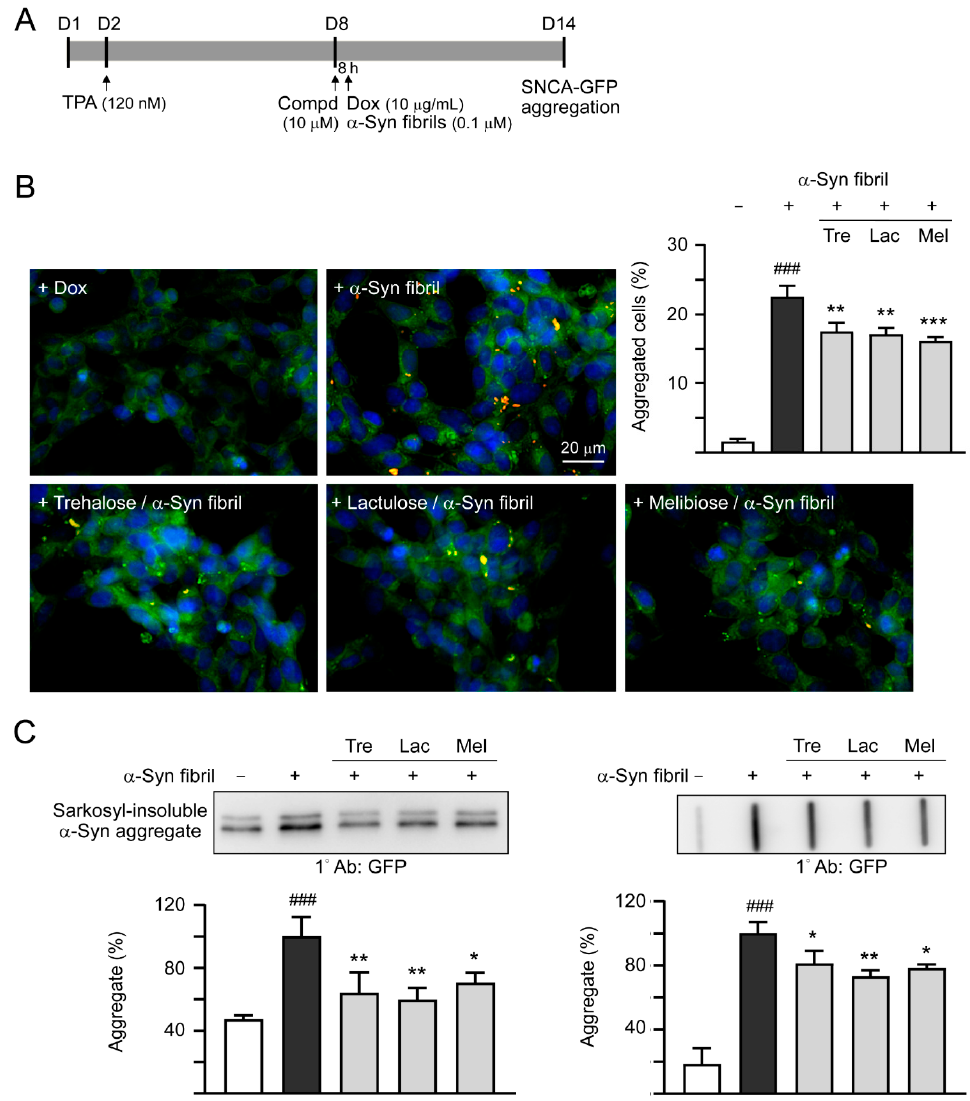
Figure 5. α -Synuclein aggregation analysis on SNCA-GFP SH-SY5Y cells. ( A ) Experimental flow chart. SNCA-GFP SH-SY5Y cells were seeded on day one, and added with TPA (120 nM) on day two to promote DAergic differentiation. On day eight, trehalose, lactulose, or melibiose (100 μ M) was added to the cells for 8 h, followed by induction of SNCA-GFP expression with doxycycline (Dox; 10 μ g/mL) and addition of preformed α -synuclein fibrils ( α -Syn fibrils, 0.1 μ M) for six days. On day 14, percentages of aggregated cells (with overlapped green and red spots) were measured by using HCA analysis of ProteoStat-stained images. In addition, sarkosyl-insoluble SNCA-GFP aggregates were measured by immunoblotting and filter trap assay with a GFP antibody. ( B ) Fluorescent microscopy images and aggregation analysis ( n = 3) of SNCA-GFP-expressing cells (green) added with or without preformed fibrils (+ Dox/+ α -Syn fibrils or + Dox/ − α -Syn fibrils), and + Dox/+ α -Syn fibrils-cells treated with trehalose (Tre), lactulose (Lac), or melibiose (Mel) for six days, with nuclei counterstained with DAPI (blue). Shown were α -Syn-GFP, ProteoStat (red), and DAPI merged images. ( C ) Western blot and filter trap analyses of α -synuclein aggregates ( n = 3) of the SNCA-GFP SH-SY5Y + Dox/+ α -Syn fibrils-cells treated with trehalose (Tre), lactulose (Lac), or melibiose (Mel). The sarkosyl-insoluble aggregates were detected with anti-GFP antibody. To normalize, the relative aggregates in SNCA-GFP SH-SY5Y + Dox/+ α -Syn fibrils-cells was set as 100%. p values: comparisons between + Dox/ − α -Syn fibrils vs. + Dox/+ α -Syn fibrils ( ### p < 0.001), or between + Dox/+ α -Syn fibrils-cells with and without disaccharide treatment (* p < 0.05, ** p < 0.01, and *** p < 0.001; one-way ANOVA with a post hoc Tukey test).